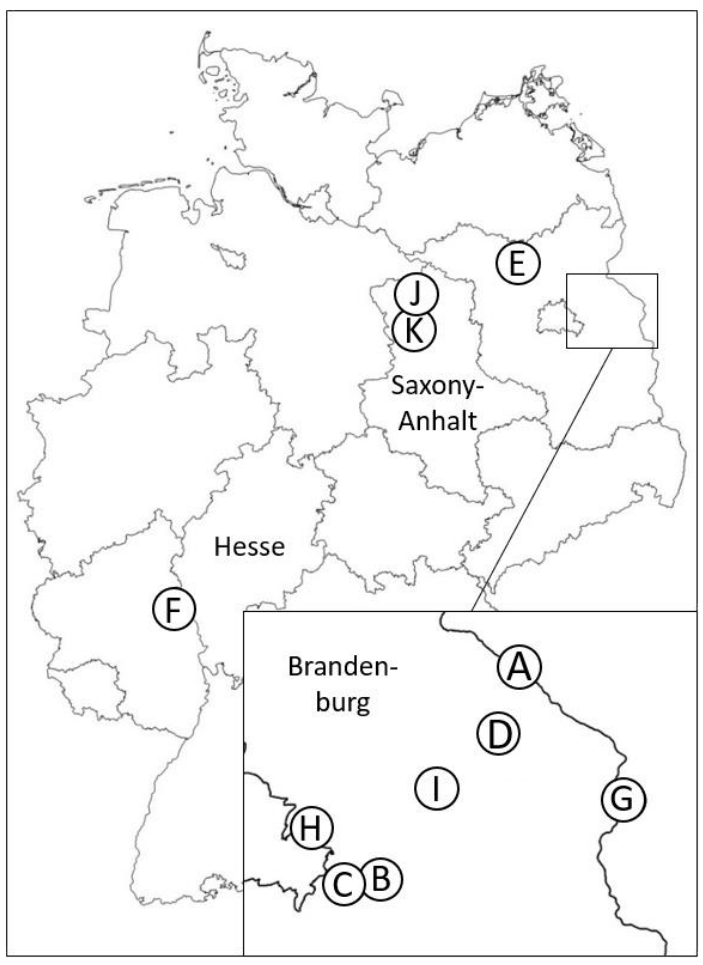
Figure 1. Geographical allocation of study regions sampled for emerging adult biting midges. A: Two locations with seven study sites; B: Two locations with three study sites; C: Two locations with three study sites; D: Four locations with six study sites; E: Two locations with four study sites; F: One location with two study sites; G. One location with two study sites; H: One location with six study sites; I: Five locations with seven study sites; J: One location with two study sites; K: One location with one study